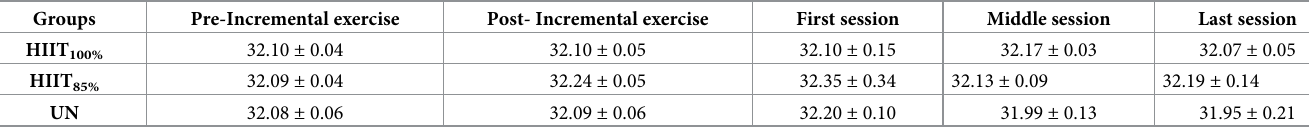
Table 4. Average ambient temperature (˚C) during the incremental exercises and during the first, middle and last training sessions.